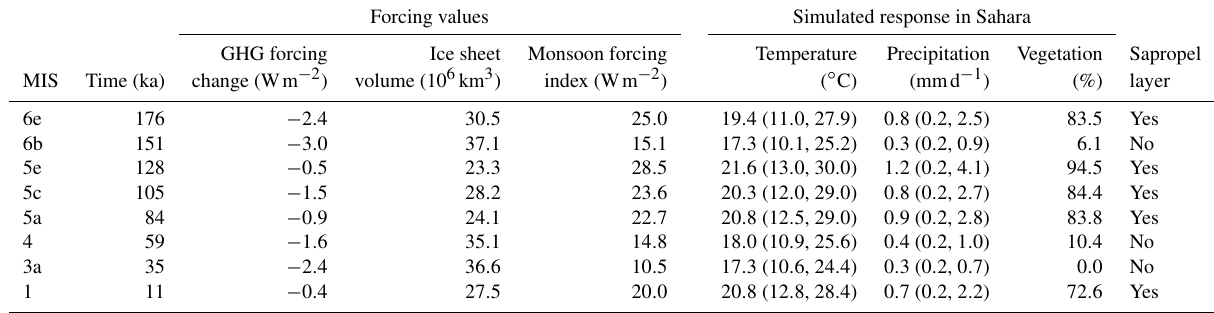
Table 2. Forcing values and results in the Sahara grid box of seasonal and annual mean values in control experiment E0, taken near maxima of the monsoon forcing index. Sapropel layers are those in Fig. 2a. Values in parentheses are winter and summer means, in that